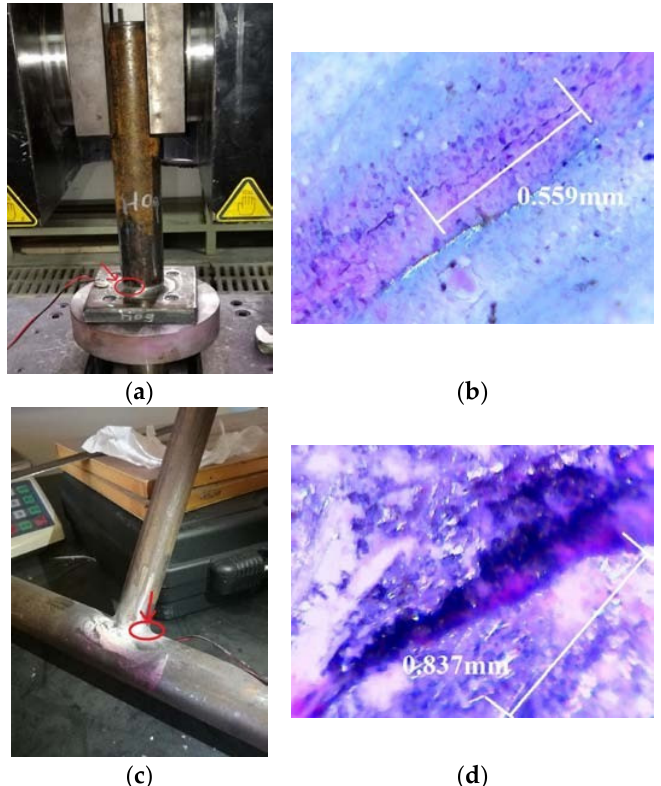
Figure 8. Crack locations in the specimens: ( a ) combination of the plate and a pipe (H09), ( b ) crack detected in the combination of the plate and a pipe (H09), ( c ) combination of two steel pipes (T04) and ( d ) crack detected in the combination of the two steel pipes (T04).